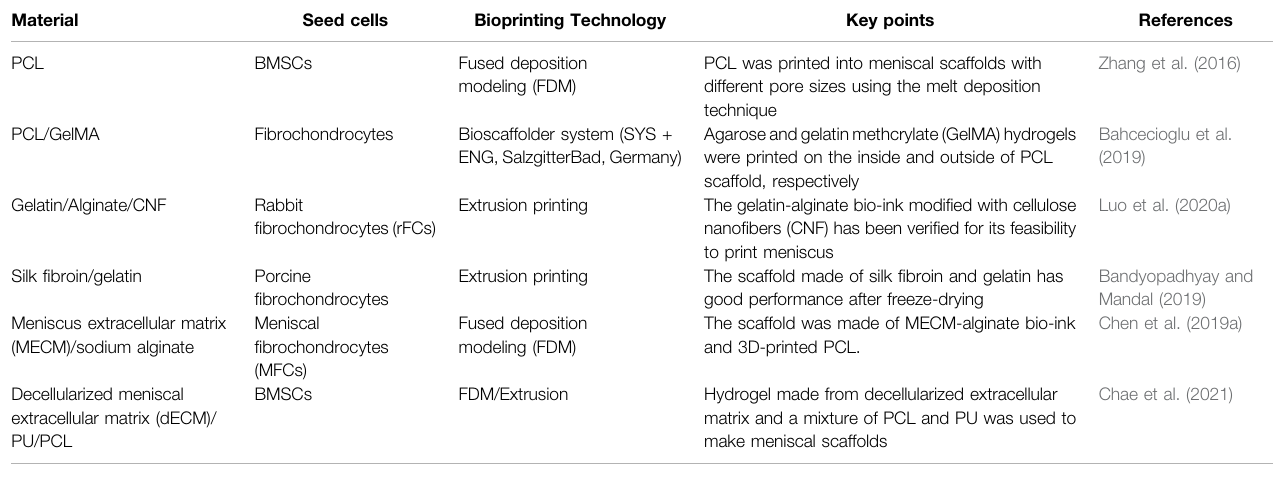
TABLE 4 | Summary of 3D-printed meniscus cartilage.